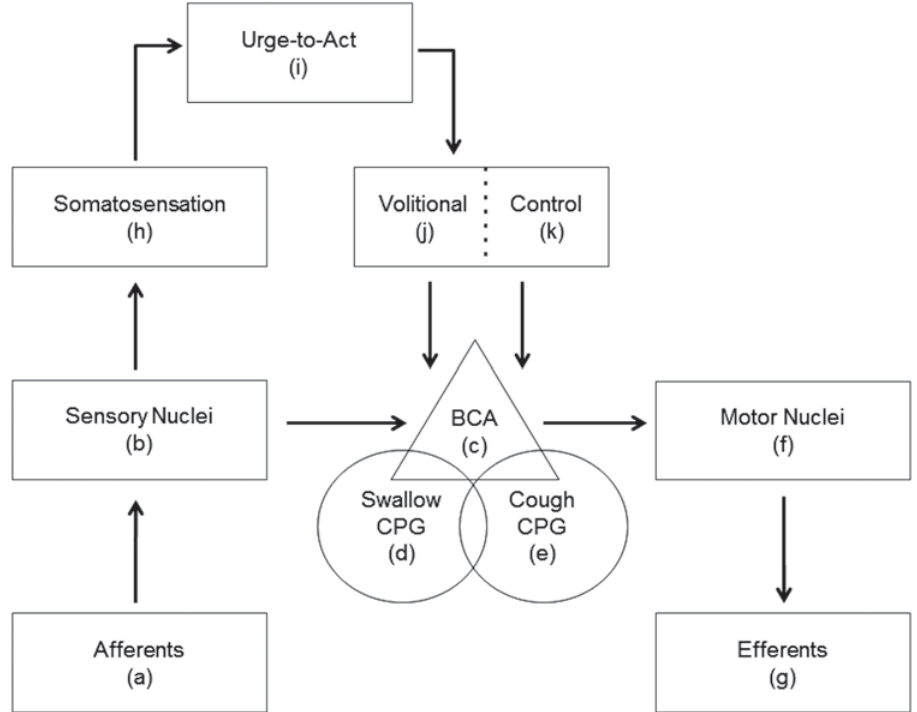
Figure 2- Proposed framework of airway protection. Cough and swallowing share afferents (a) that are essential to the (cid:4)(cid:26)(cid:4)3(cid:4)(cid:25)3(cid:4)(cid:13)(cid:26)(cid:2)(cid:25)(cid:26)+(cid:2)&(cid:13)+(cid:4)4(cid:5)(cid:25)3(cid:4)(cid:13)(cid:26)(cid:2)(cid:13)5(cid:2)3(cid:6)(cid:7)(cid:2)6(cid:7)(cid:6)(cid:25)(cid:28)(cid:4)(cid:13)(cid:12)(cid:27)(cid:10)(cid:2)(cid:11)(cid:6)(cid:4)(cid:27)(cid:2)(cid:25)55(cid:7)(cid:12)(cid:7)(cid:26)3(cid:2)7(cid:25)8(cid:2)(cid:4)(cid:26)5(cid:13)(cid:12)&(cid:25)3(cid:4)(cid:13)(cid:26)(cid:2)(cid:4)(cid:27)(cid:2)3(cid:6)(cid:7)(cid:26)(cid:2)(cid:27)(cid:7)(cid:26)3(cid:2)3(cid:13)(cid:2)3(cid:6)(cid:7)(cid:2)(cid:27)(cid:7)(cid:26)(cid:27)(cid:13)(cid:12)9(cid:2)(cid:26))(cid:5)(cid:8)(cid:7)(cid:4)(cid:2)768(cid:2)(cid:8)(cid:13)(cid:5)(cid:25)3(cid:7)+(cid:2)(cid:4)(cid:26)(cid:2) the brainstem. There, the behavioral control assembly (BCA) (c) will receive the afferent information and exert control